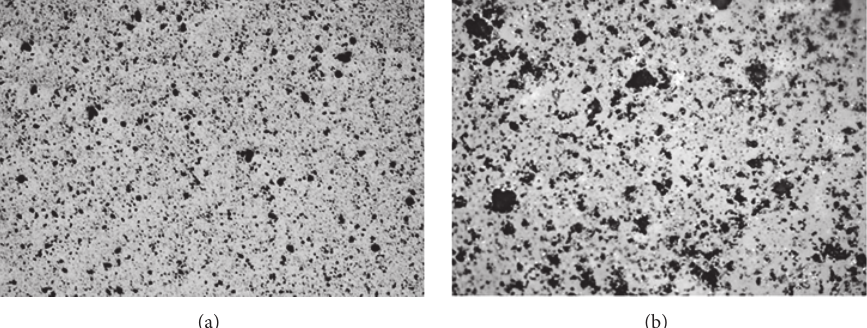
Figure 7: Optical microstructure images of ferroelectric ceramics, obtained at 10x and 100x, (a) and (b)